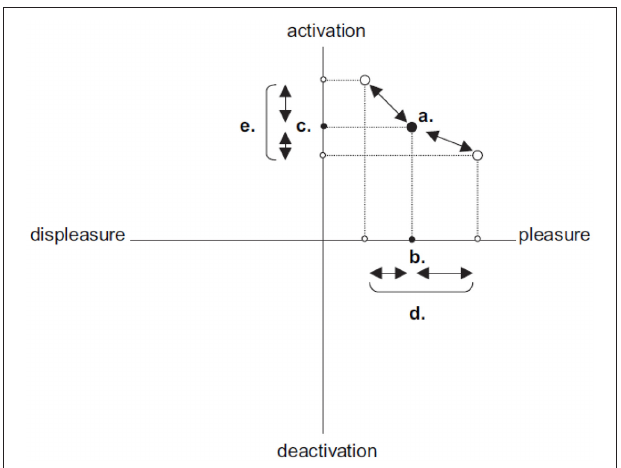
FIGURE 2 | Graphical example of valence and activation variability. From “Individual differences in core affect variability and their relationship to personality and psychological adjustment” by Kuppens et al.